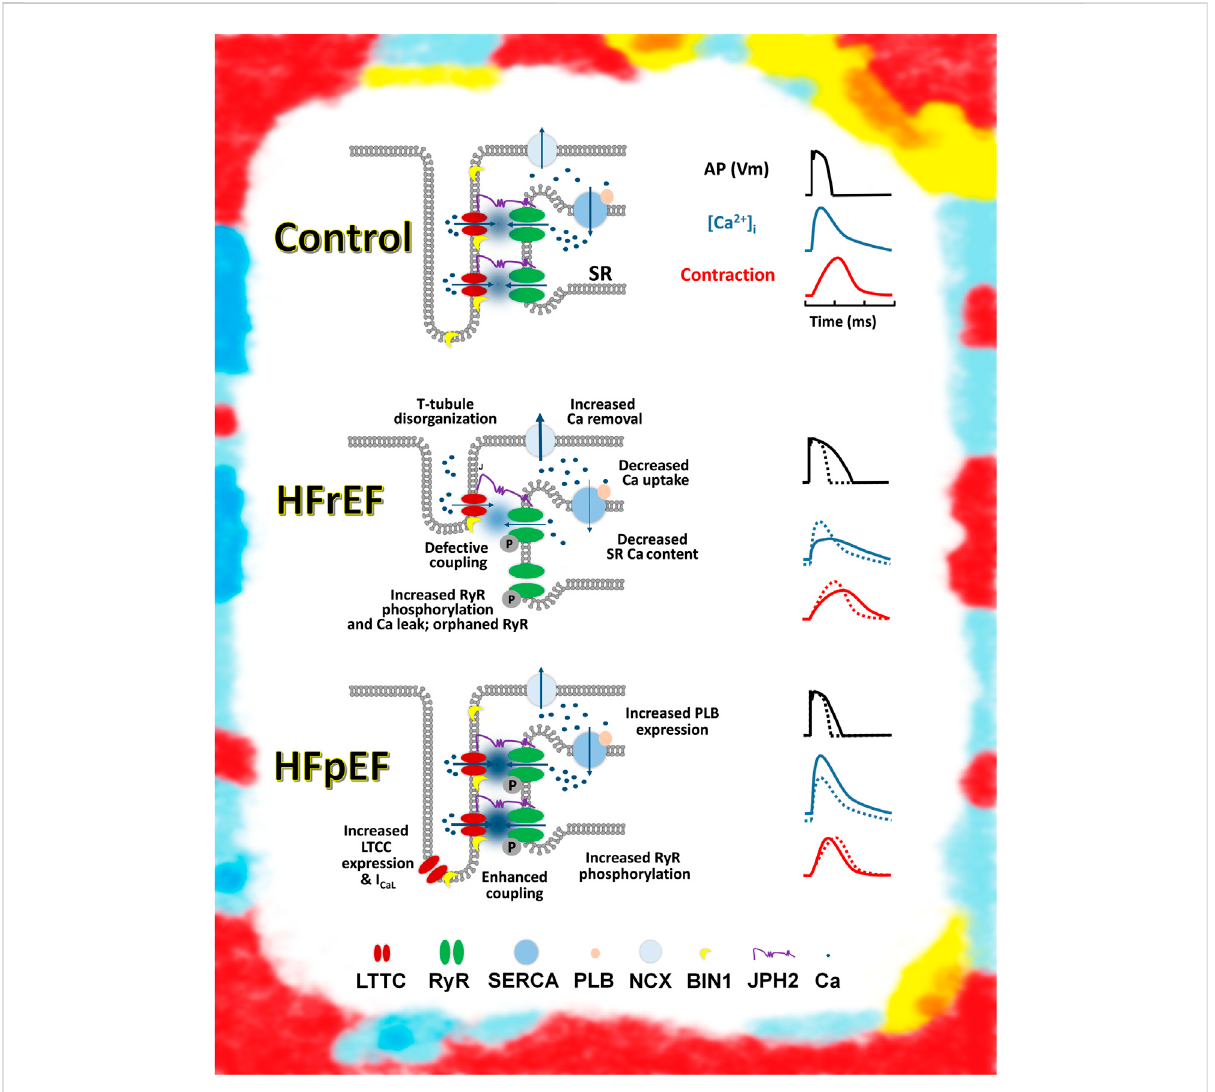
FIGURE 1 Schematic representation of excitation contraction coupling in control, HFrEF, and HFpEF cardiomyocytes Top: Control (healthy) and ECC (left).Schematicactionpotential,Catransient,andcontraction(right).Middle:majorchangeobservedinECCinHFrEFcardiomyocytes(left).Change in action potential, Ca transient, and contraction, compared with a control (dashed lines) (right). Bottom: change observed in ECC in HFpEF cardiomyocytes by Kilfoil et al. (2020) (left). Change in action potential, Ca transient, and contraction, compared with a control (dashed lines) (right). Artistic rendering inspired by the work of Mark Titchner on billboards in the United